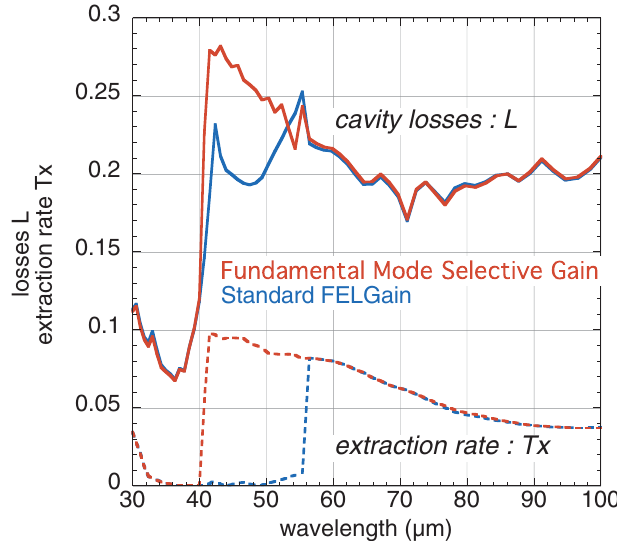
FIG. 7. (Color) Simulation, total cavity losses L and hole cou- pling extraction rate T X as a function of wavelength, for toroidal cavity.